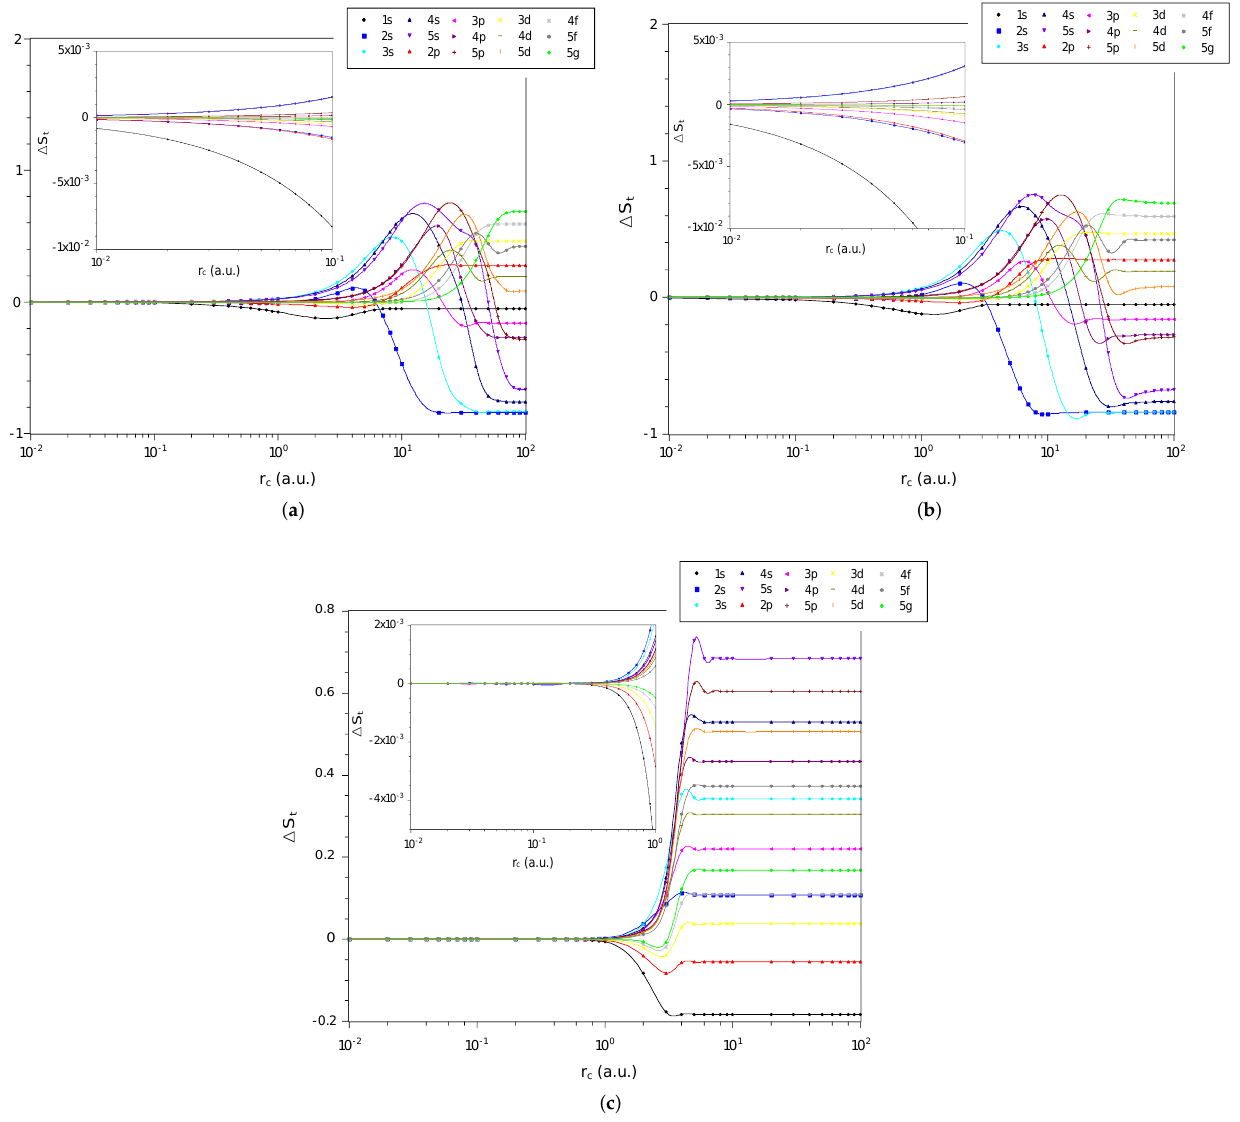
Figure 3. Values of ∆ S t in different quantum states as a function of r c on a logarithmic scale for the ( a ) hydrogen confined, ( b ) ion-sphere, and ( c ) confined harmonic oscillator. Note that a particular state of a given system with ∆ S t > 0 ( ∆ S t < 0) has a larger (smaller) entropy sum than the same state for a particle confined in a cage for a given radius of confinement. That is, several states of the three systems under study have a lower entropy sum when free ( r c >> 1) than when subjected to strong confinement. For intermediate values of r c we can observe oscillations in ∆ S t , confirming that confinement affects the position and momentum spaces